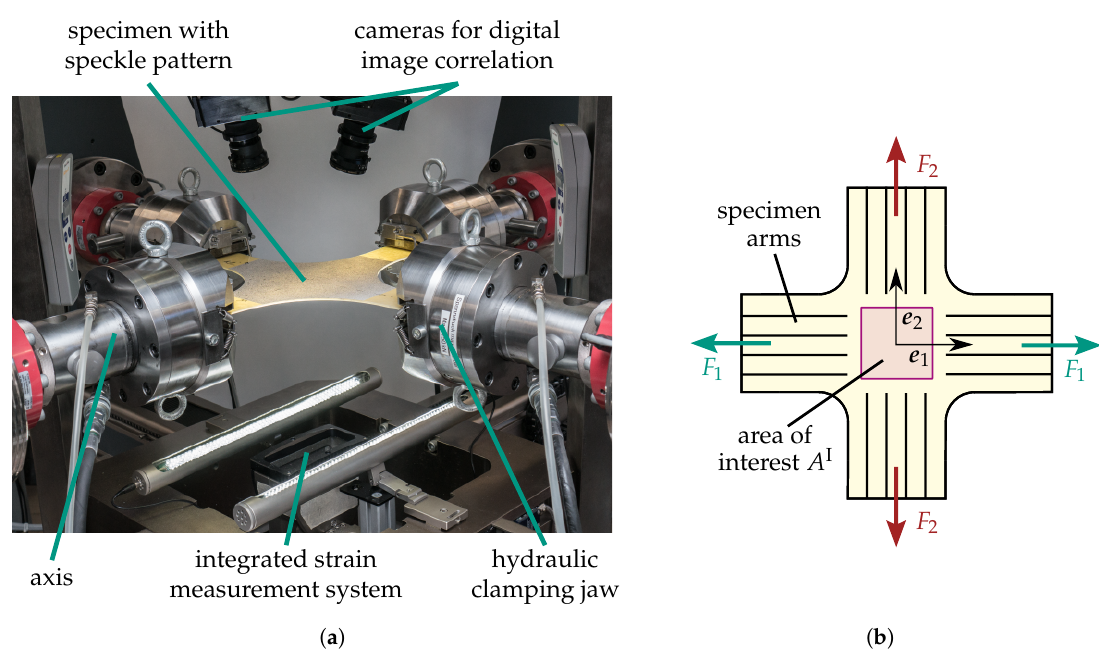
Figure 1. Biaxial tensile testing setup and an exemplary cruciform specimen. ( a ) Biaxial tensile testing device; ( b ) Cruciform